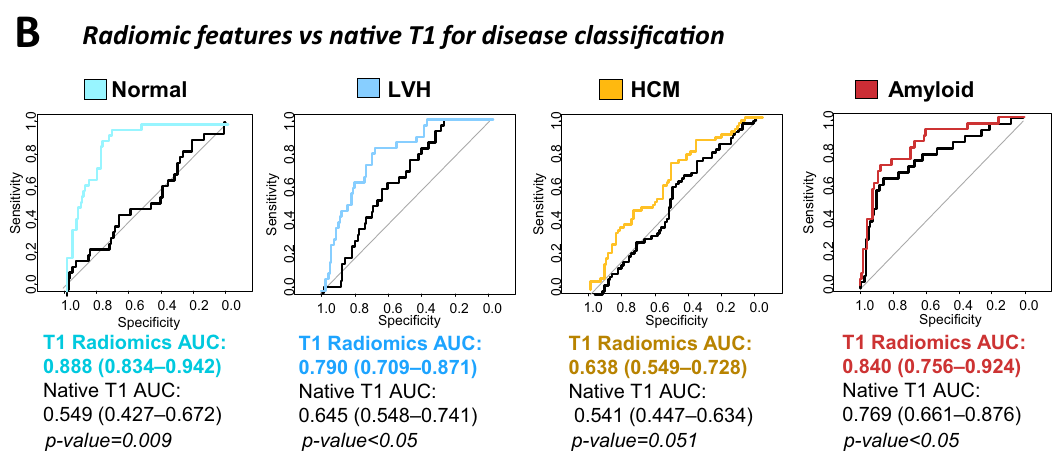
Figure 5. ( A ) Boxplots showing the distribution of the finally selected radiomic features in the testing cohort between disease classes. p values are derived from Kruskal–Wallis. ( B ) The incremental value of the final radiomic features for disease classification vs. native T1 (mean) values was demonstrated in relevant receiver operating characteristic